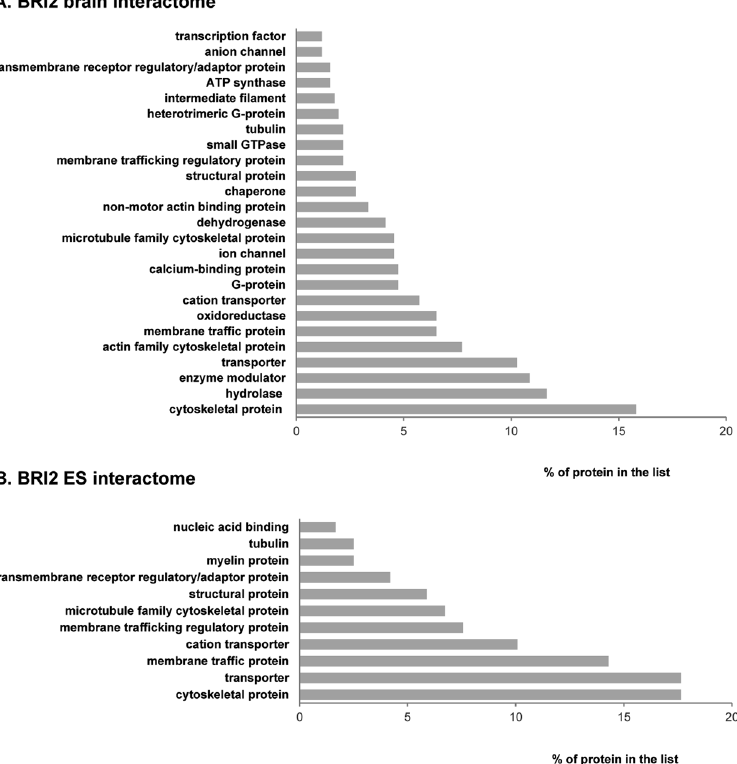
Figure 1. Panther Protein class of the novel BRI2 interactome using the PANTHER online resource. The percentage of the BRI2 interacting proteins in each category was calculated and plotted. ( A ) Panther Protein class of all the identified BRI2 interacting proteins (BRI2 brain interactome). ( B ) Panther Protein class of the identified brain-enriched or specific BRI2 interacting proteins (BRI2 brain ES